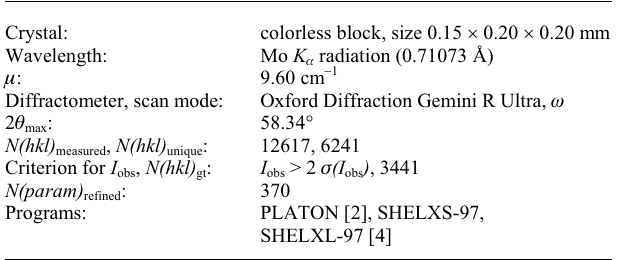
Table 1. Data collection and